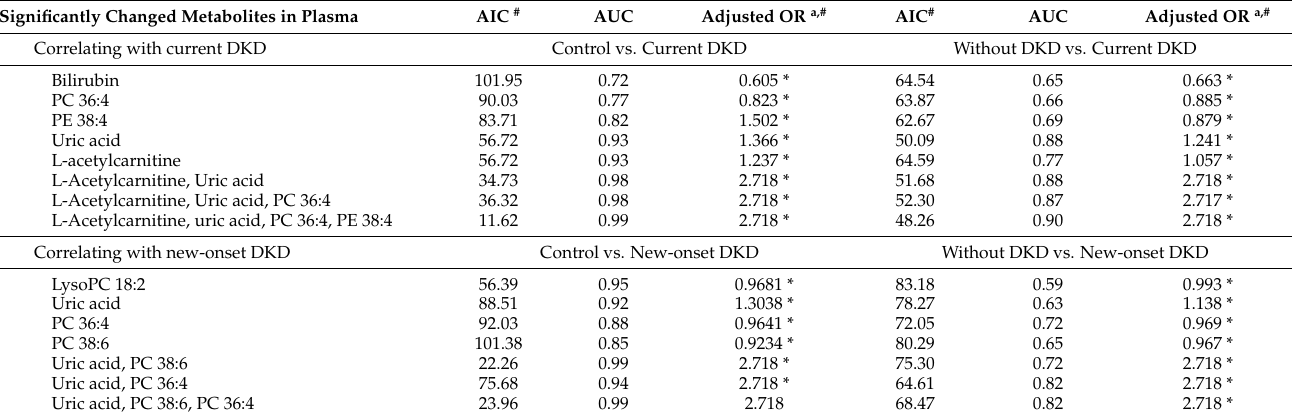
Table 5. Association of metabolite combinations in plasma samples from patients with diabetic kidney disease with current DKD or new-onset DKD.